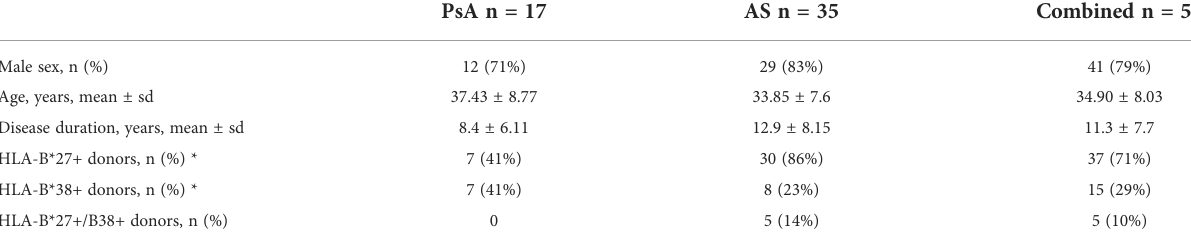
TABLE 1 Patient cohort